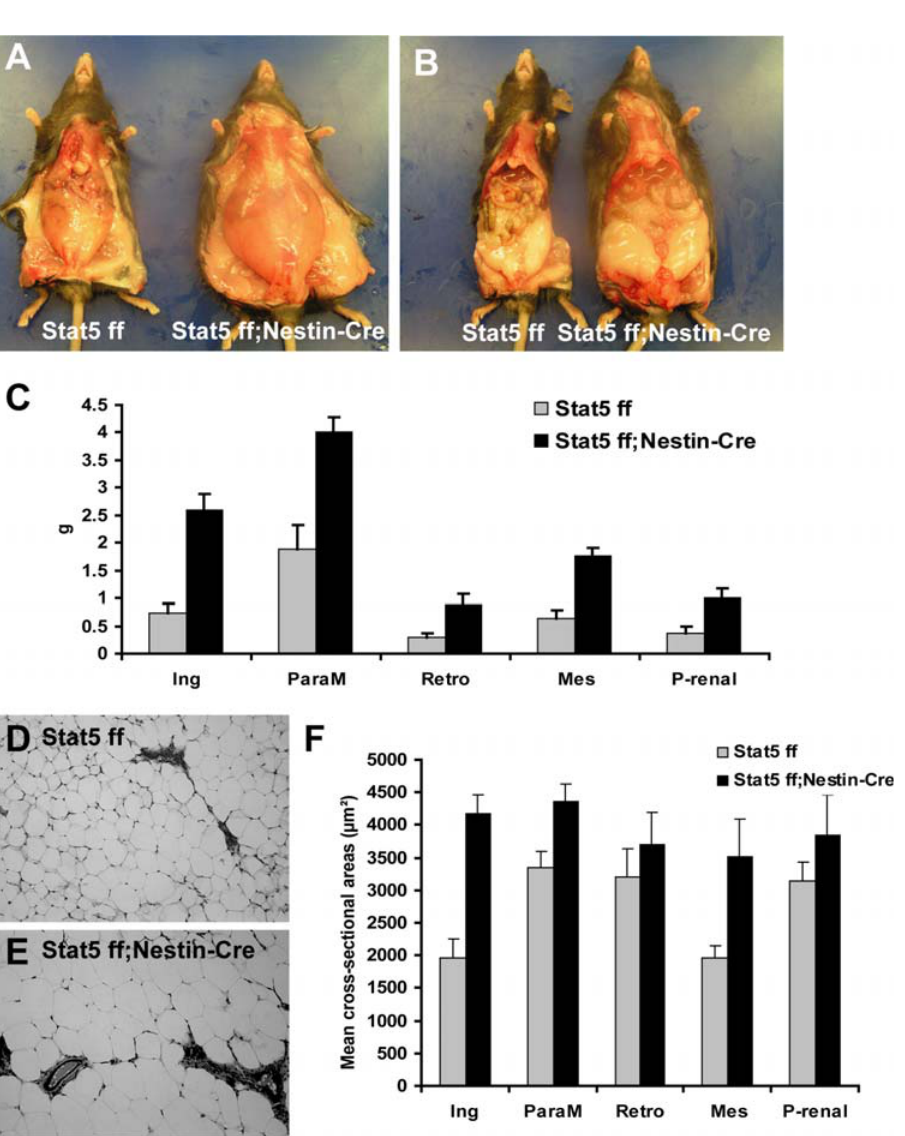
Figure 4. Analysis of fat depots and adipocyte size fat analysis from 22 week-old female mice. Subcutaneous (A) and visceral (B) fat were increased in Stat5 fl/fl; Nestin-Cre mice, compared to Stat5 fl/fl control mice. (C) Unpaired t-test was used for comparison of fat pad weights from Stat5 fl/fl; Nestin-Cre and Stat5 fl/fl control mice. Ing (inguinal, t(8)=5.6, P , 0.001), ParaM (parametrial, t(8)=4.1, P=0.004), Retro (retroperitoneal, t(8)=2.9, P=0.019), Mes (mesenteric, t(8)=5.3, P , 0.001)) and P-renal (perirenal, t(8)=3.2, P , 0.013). See figure 3 for body composition and body weight data. (D–E) Images of cross-sectional adipocytes from Stat5 fl/fl (D) and Stat5 fl/fl; Nestin-Cre mice (E). (F) Comparison of cell size distribution between two different genotypes for each fat pad. Values are mean cross-sectional area of each fat pad 6 SEM (n=3–5 mice per group). Cross-sectional areas less than 100 m m 2 were considered artifacts generated during image processing and were not used for statistical analysis. Adipocytes from Stat5 fl/fl; Nestin-Cr mice were significantly larger in inguinal fat (t(8)=5.3, p,0.001), parametrial fat (t(8)=2.8, p=0.02) and mesenteric fat (t(6)=3.1, 0.02).